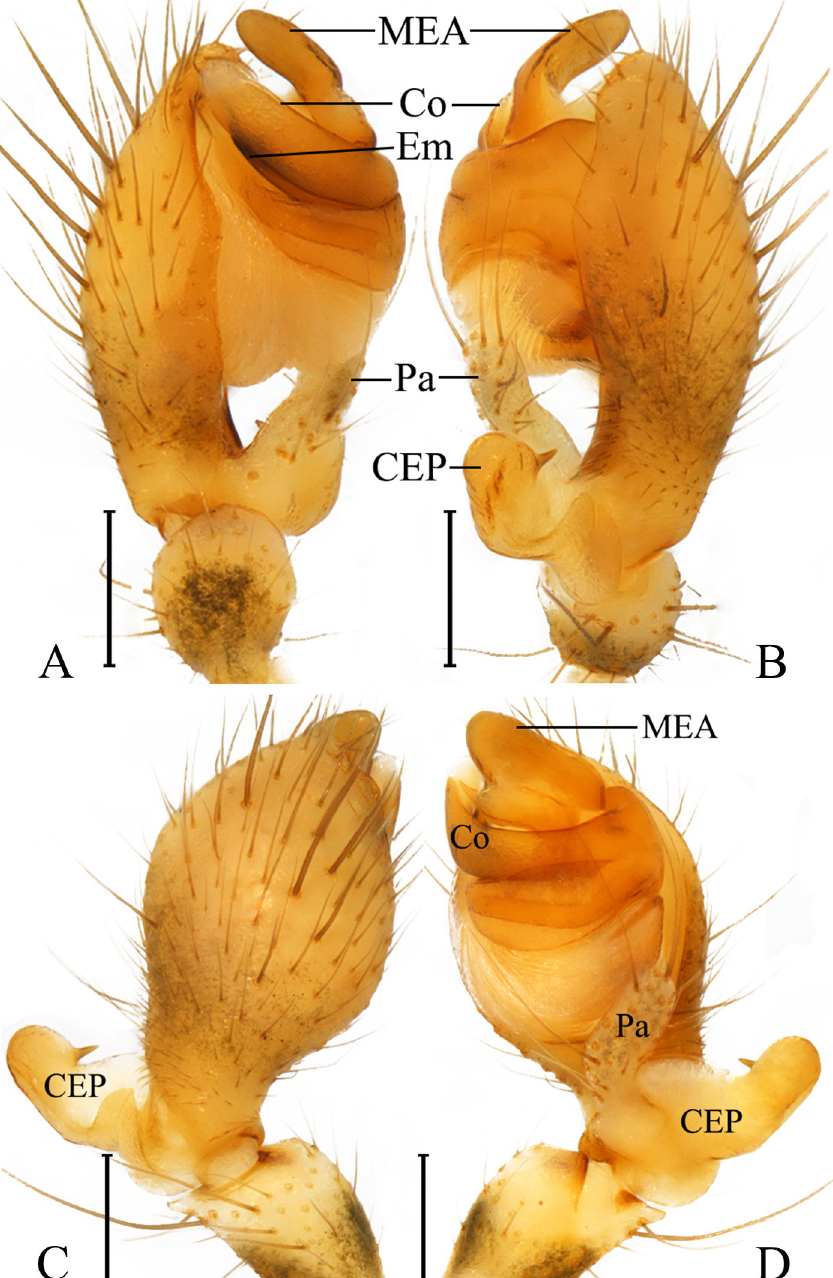
Fig. 10. Meta yani sp. nov. Left palp of holotype ♂ (HNU-Yan021004). A . Prolateral view. B . Retrolateral view. C . Dorsal view. D . Ventral view. Scale bars: 0.2